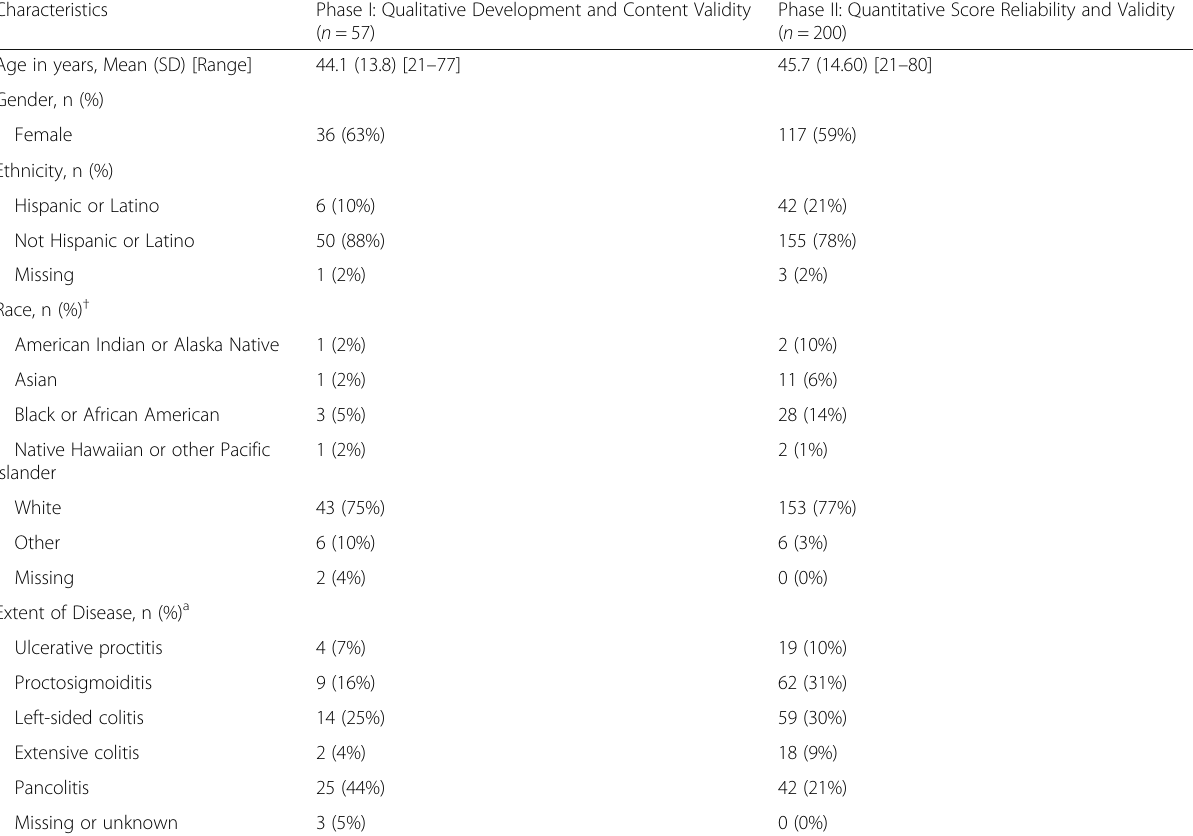
Table 1 Patient Demographic and Clinical Characteristics, by Study Phase* Characteristics Phase I: Qualitative Development and Content Validity ( n =